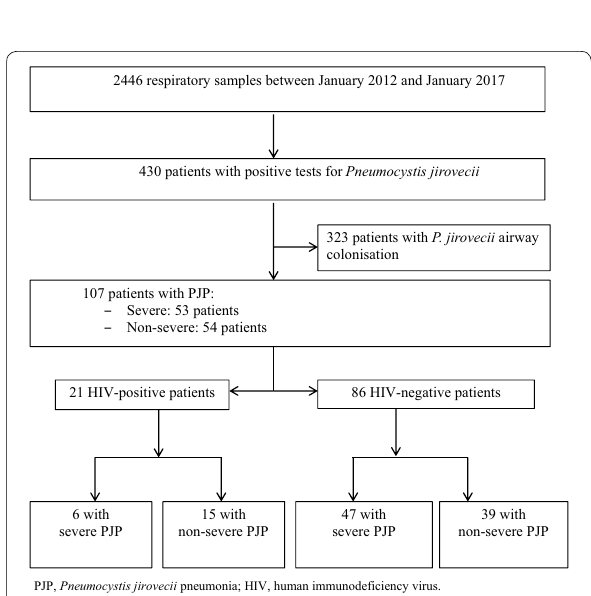
Fig. 1 Flow chart. PJP, Pneumocystis jirovecii pneumonia; HIV, human immunodeficiency